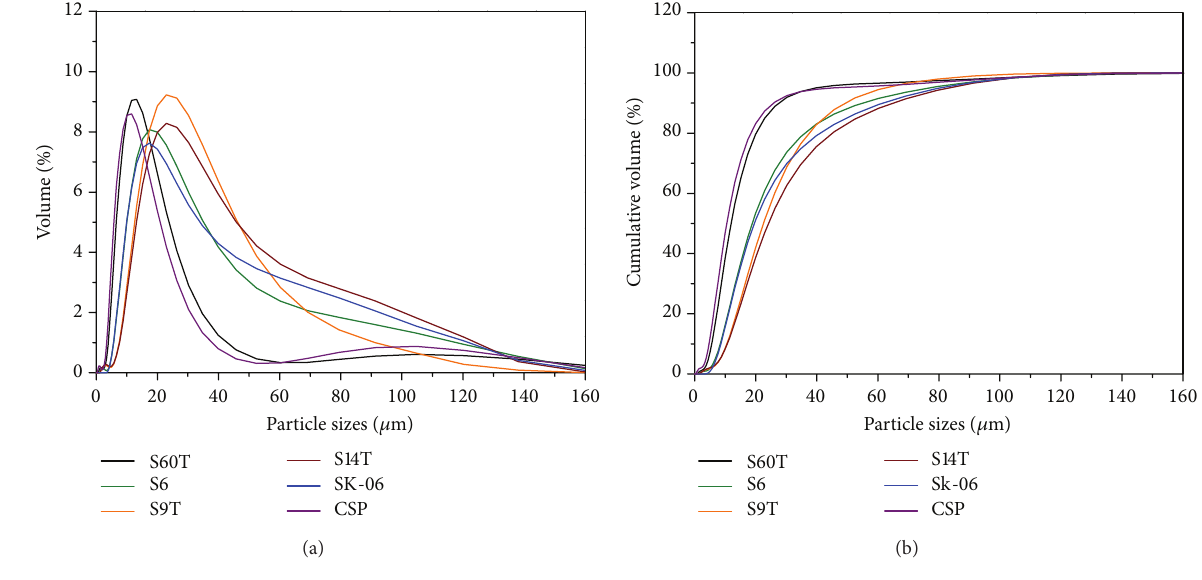
Figure 5: Size distribution of strontium ferrite